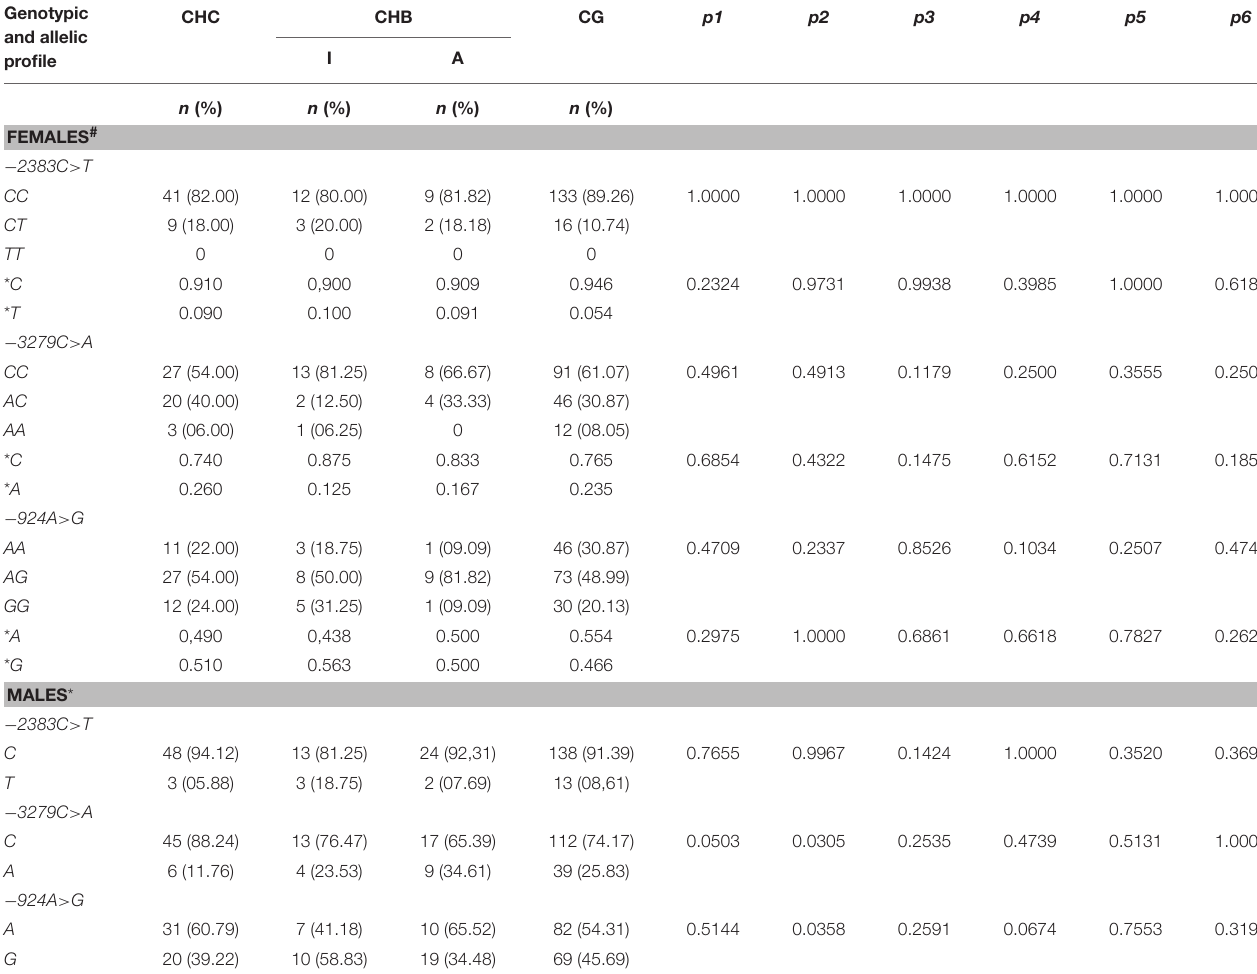
TABLE 2 | Genotype and allele polymorphism frequencies in the FOXP3 gene promoter region in patients with chronic hepatitis B and C virus infections. Genotypic and